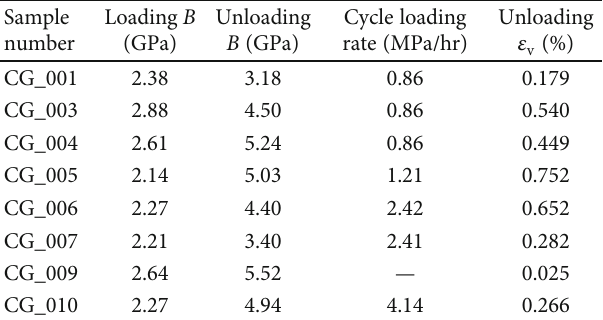
1 1.50 0.5 Strain (%) Figure 5: Volumetric strain as a function of e ff ective stress. Table 3: Values of the bulk modulus B measured during hydrostatic loading at test inception and unloading at test ending. Unloading ε v is the volumetric strain calculated from a third-degree polynomial best fi t of the unloading curve. Test duration indicates the number of days each test lasted. Cycle loading rate represents the rate of e ff ective stress change during cyclic